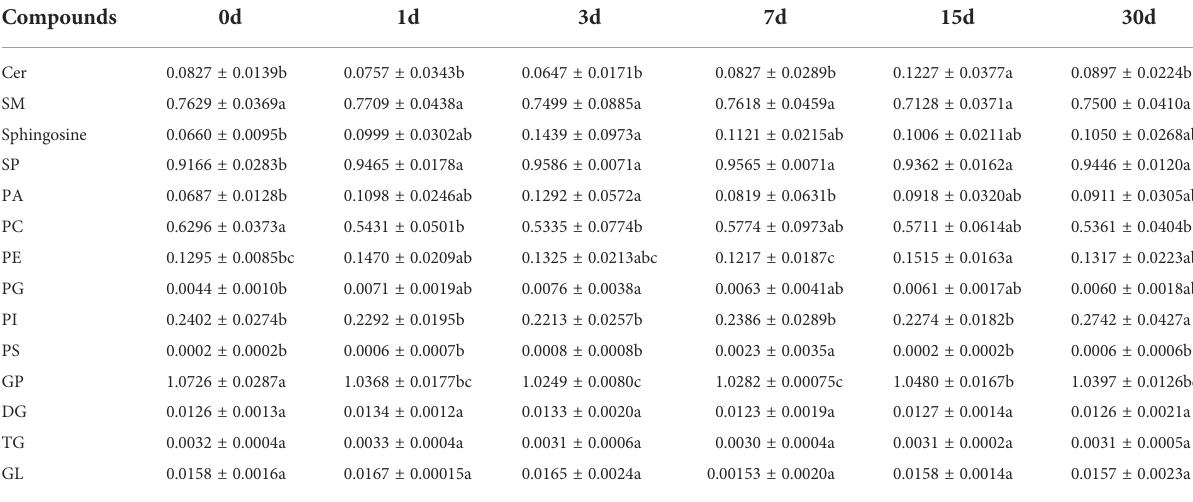
TABLE 1 Content of different lipid subclasses in pearl oyster serum after transplantation. Compounds